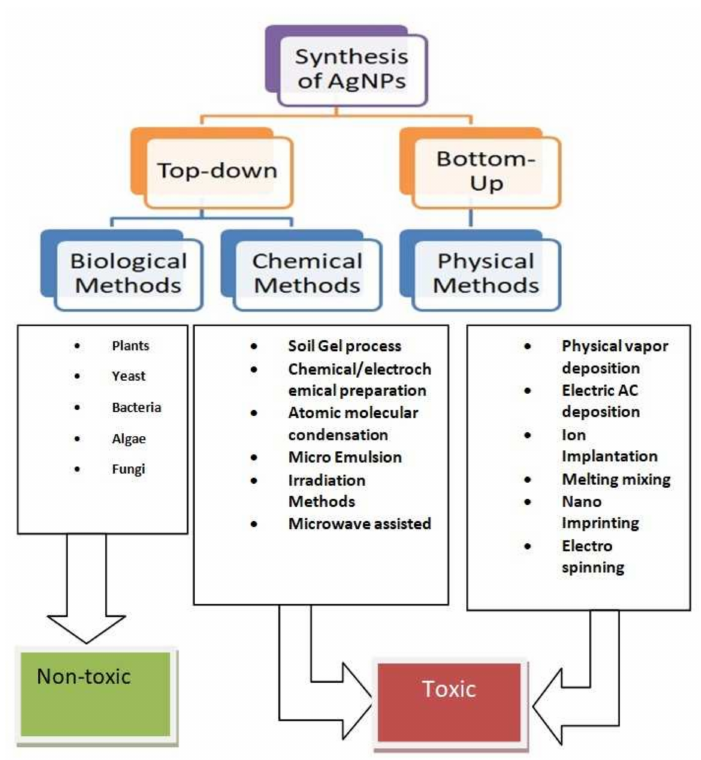
Figure 2. Different method used for the synthesis of (AgNPs)